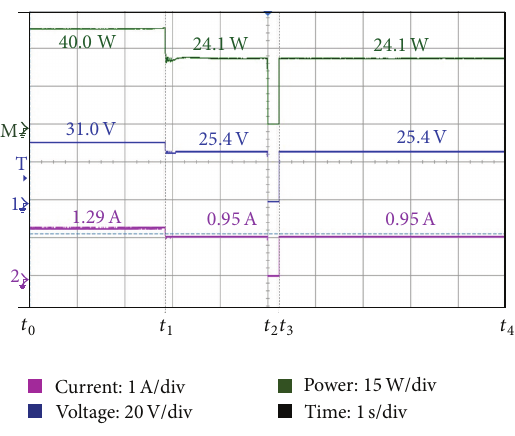
Figure 15: Experimental results: